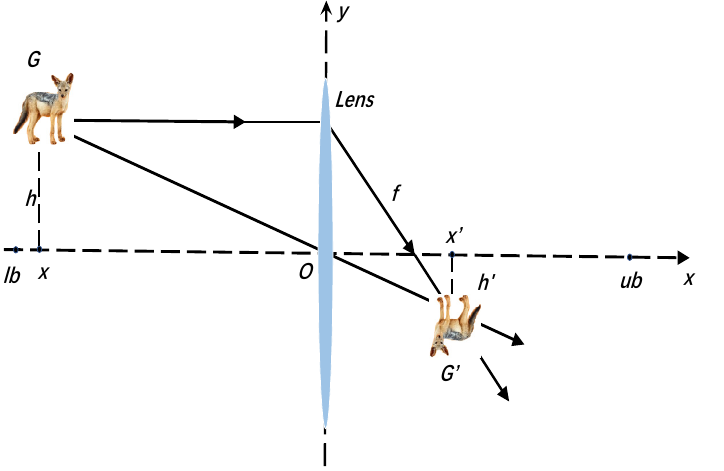
Figure 1. The principle of lens-imaging learning strategy.